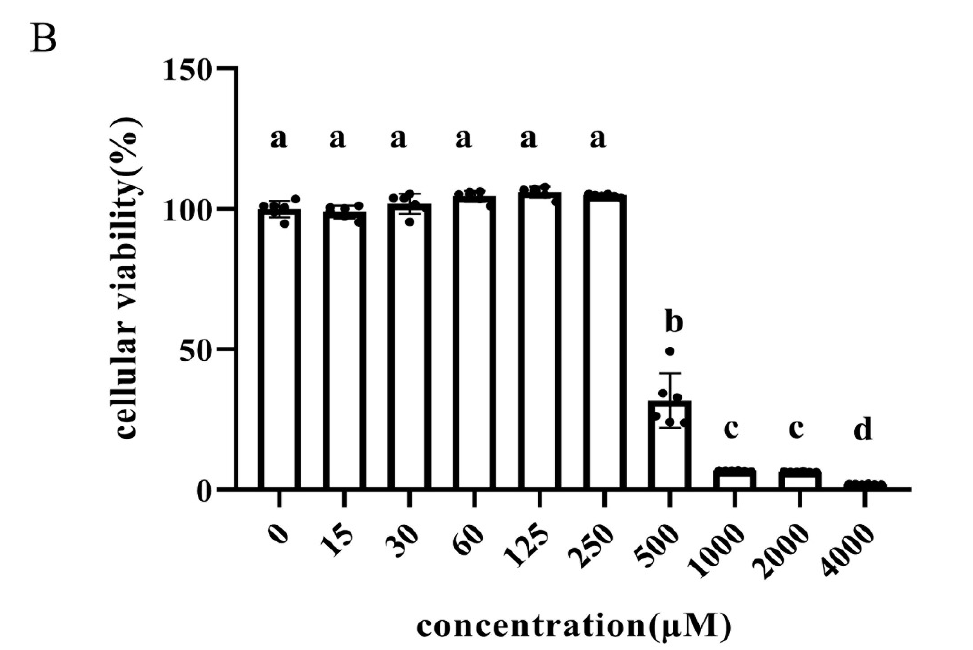
Figure 1. Effects of reuterin on the cellular viability of HD11 cells. Cells were incubated with different concentrations of reuterin (0 to 4000 µ M) for 12 h. ( A ) The representative cellular morphological changes were observed in microscope with 100 × magnification. Scale bar = 100 µ m. ( B ) Cell viability was measured by CCK8 assay. Data are expressed as the mean ± SD with six independent replicates ( n = 6). Different lowercase letters above column mean significant difference between groups ( p < 0.05).